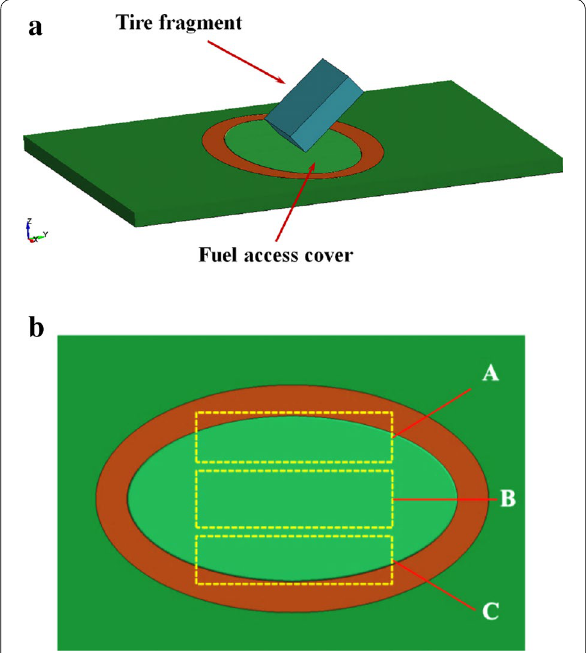
Figure 8 ( a ) Scenario of the fuel access cover subjected to large tire fragment impact and ( b ) three regions of fragment